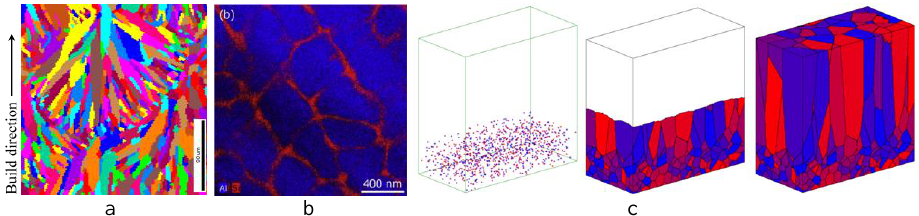
Fig. 1. Images of a cross-sectional plane of AlSi10Mg produced by selective laser melting: (a) EBSD, (b) Al and Si X-ray map [5], – and (c) steps of SSP-design of an AM